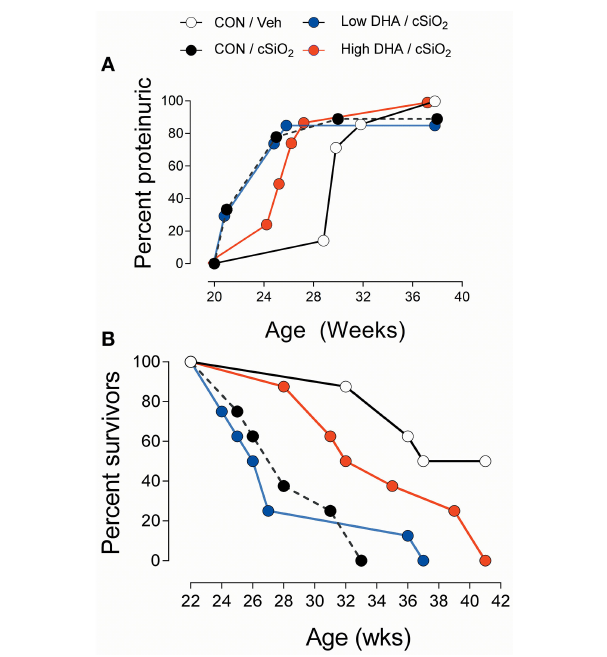
FIGURE 12 | High DHA diet delays cSiO 2 -triggered onset of proteinuria and prolongs survival in cSiO 2 -treated lupus-prone NZBWF1 mice. Animals in Cohort 2 were initiated on control diets 1 week following the final cSiO 2 instillation and animals monitored for proteinuria ( ≥ 300 mg/dl) using clinical dipsticks (A) and for survival using moribund criteria (B)